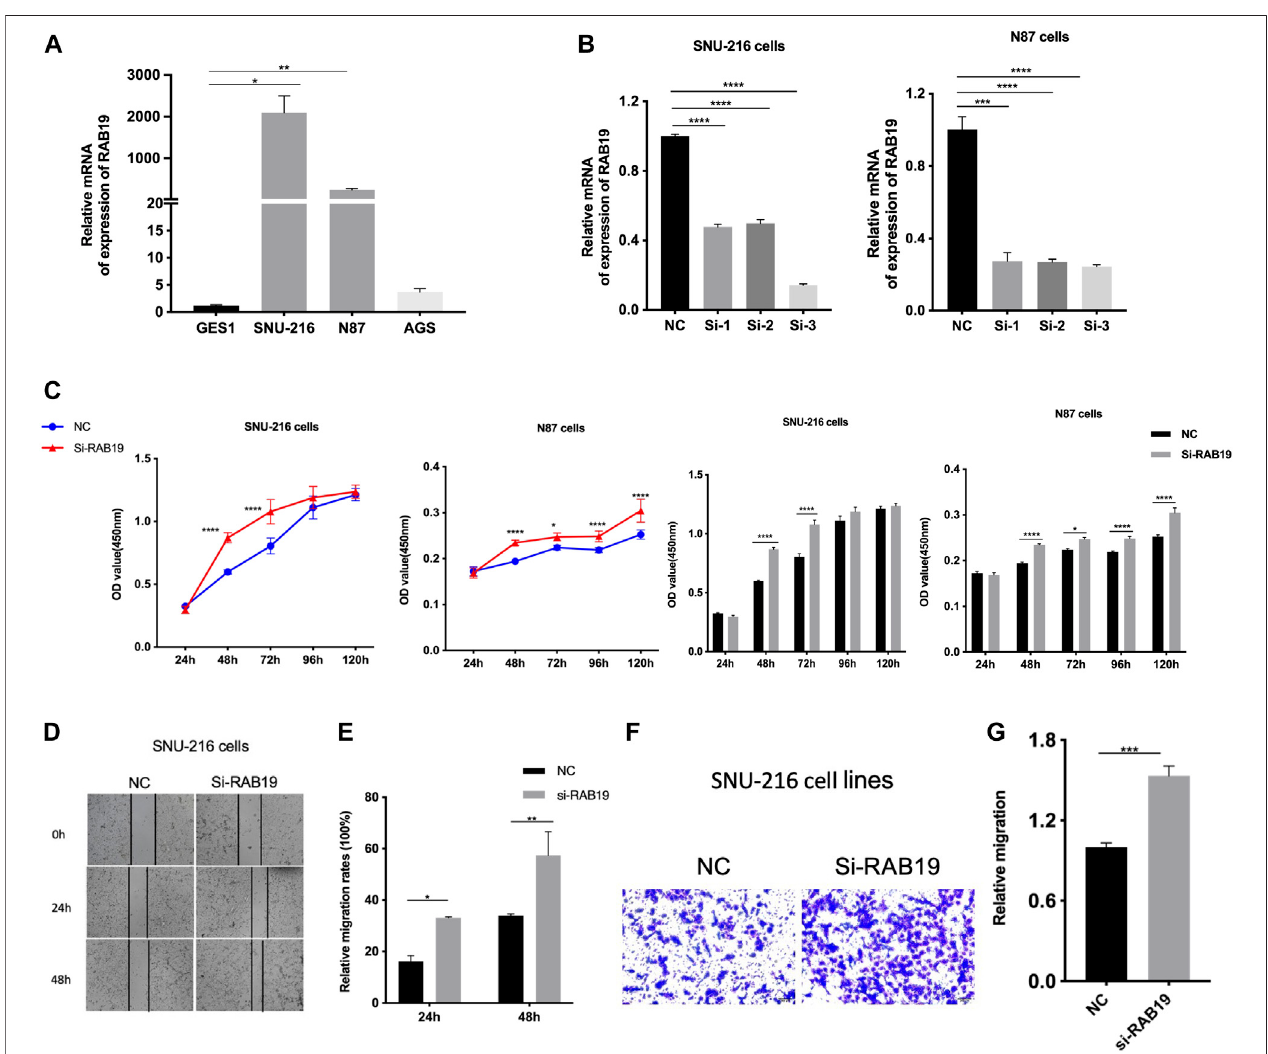
FIGURE 9 | Knockdown of RAB19 promotes migration and proliferation of gastric tumor cells (A) In the STAD cell lines SNU-216, N87, AGS, and normal gastric epithelial cell line GES1, the relative expression level of RAB19 was detected by RT-PCR (B) In the SNU-216 and N87 cell lines, the transfection ef fi ciency of si-RAB19 was detected by RT-PCR (C) In the SNU-216 and N87 cell lines, the effect of RAB19 knockdown on the proliferation was detected by the CCK-8 assay (D) Representativeimagesfromthewoundhealingassay (E) AfterknockdownofRAB19,theresultsofwound-healingassaywereanalysed (F) Representativeimages from the transwell assay (G) In the SNU-216 cell lines, the transwell assay results after knockdown of RAB19 were statistical analysed. *** p < 0.001, ** p < 0.01, and * p < 0.05.